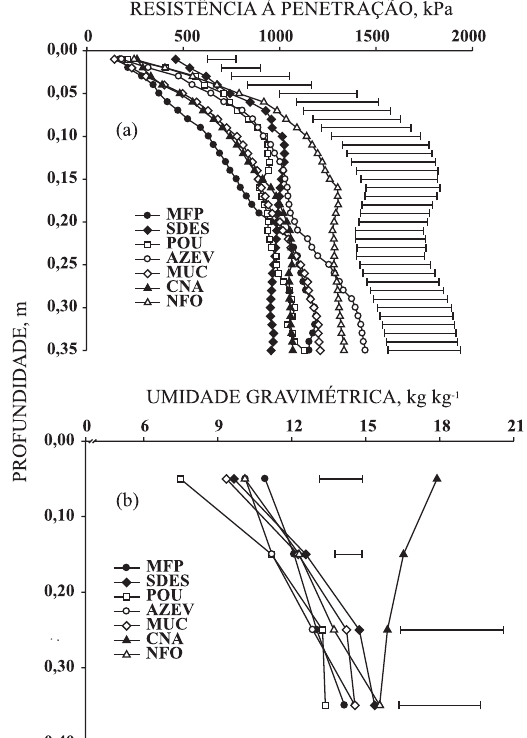
Figura 1. Resistência do solo à penetração (a) e umidade gravimétrica (b) em um Argissolo Vermelho submetido a diferentes sistemas de culturas em plantio direto, após 16 anos de experimentação. (MFP: milho + feijão-de-porco/ soja; SDES: solo descoberto; POU: milho/pousio/ soja; AZEV: milho/azevém + ervilhaca/soja; MUC: milho + mucuna/soja; CNA: campo nativo; NFO: milho/nabo forrageiro/soja). As barras horizontais correspondem à diferença mínima significativa pelo teste de Tukey (p <